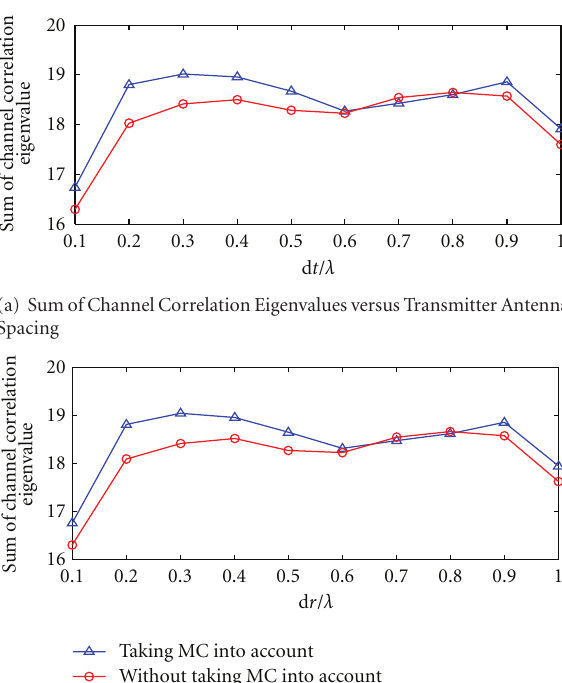
(b) Sum of Channel Correlation Eigenvalues versus Receiver Antenna Spacing Figure 1: Mutual coupling e ff ects on the sum of channel correlation matrix eigenvalues. (a) Sum of eigenvalues versus transmitter antenna element spacing; (b) Sum of eigenvalues versus receiver antenna element